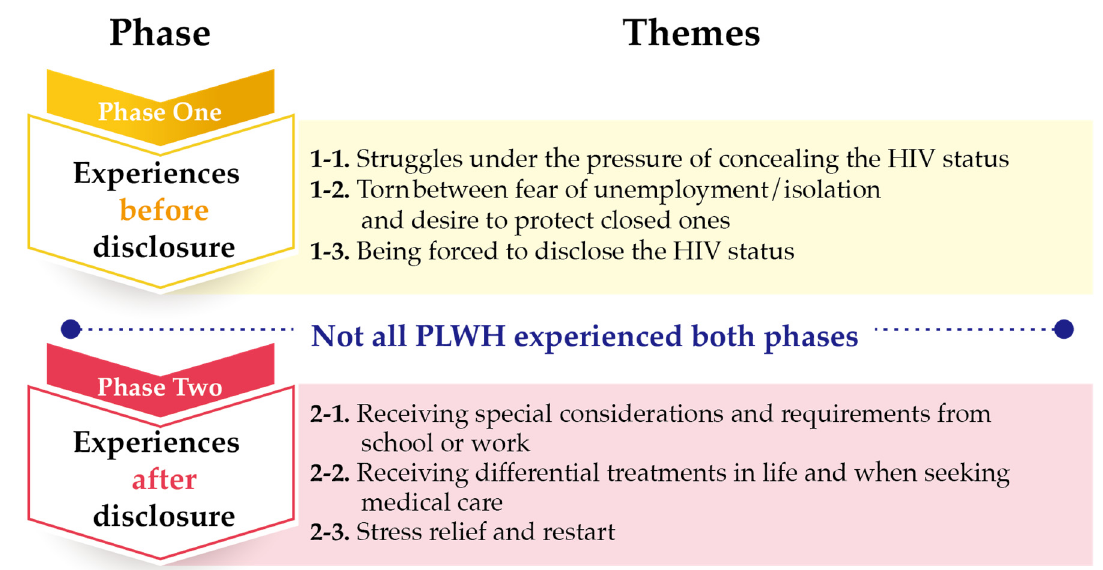
Figure 1. Summary of phases and themes.